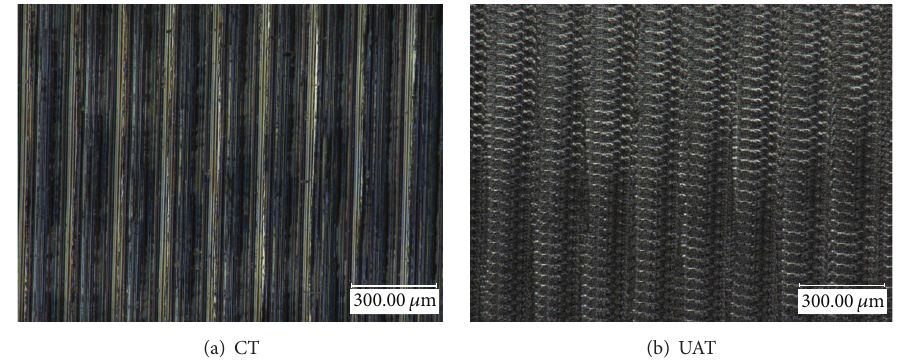
Figure 12: Surface topography magnified 200 times in UAT and CT.